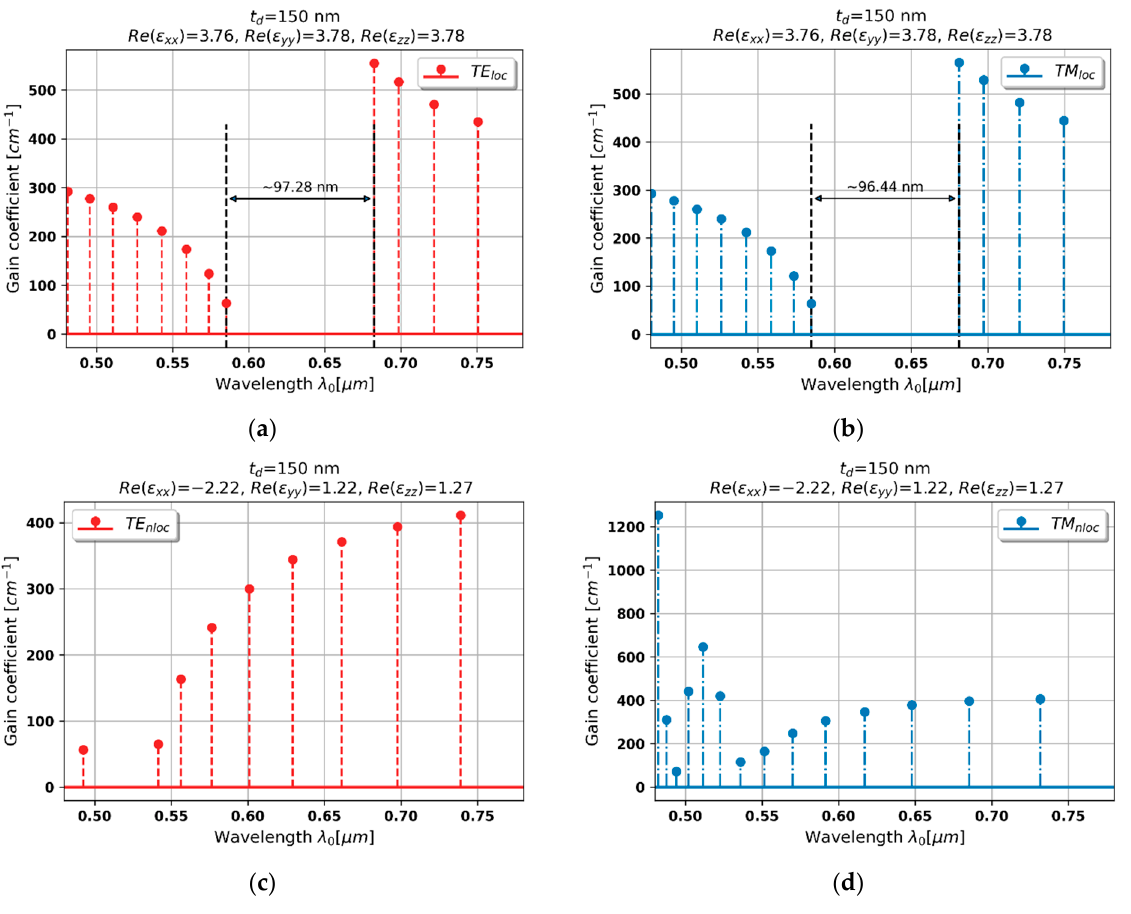
Figure 7. Modal spectra for TE ( a , c ) and TM-polarized light ( b , d ) for a PHC laser based on hyperbolic medium with t ZnO = 150 nm dielectric layer (black double-headed arrow denotes spectral width of stop band of the spectrum).